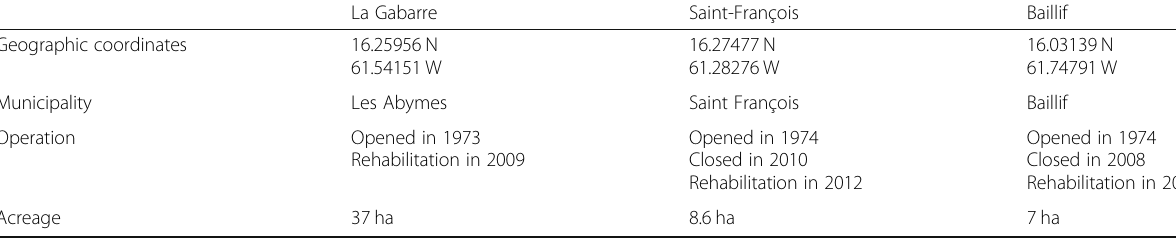
Table 1 Description of the three main open landfills in the Guadeloupe archipelago La